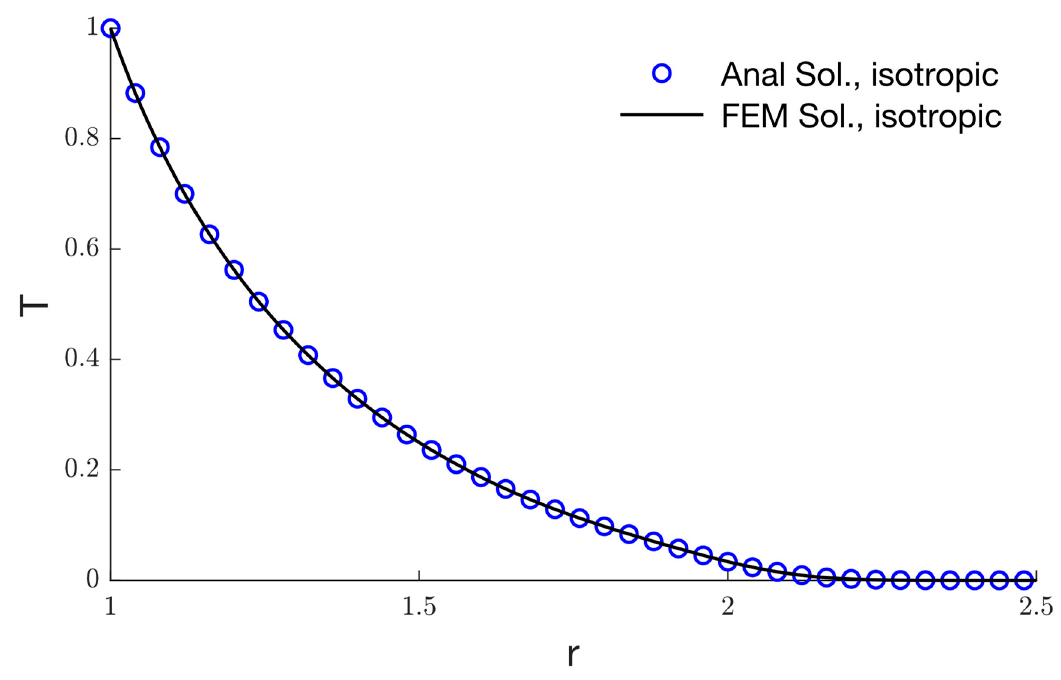
Figure 14. The temperature variation 𝑇 for isotropic material.